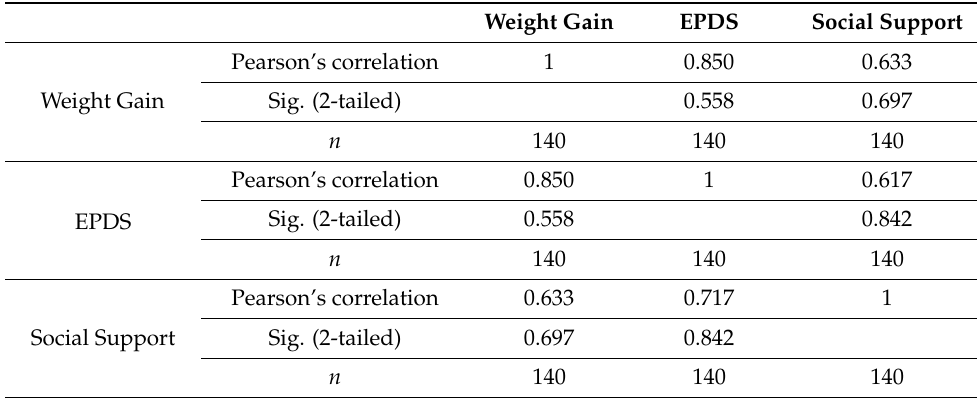
Table 7. Relations between Weight Gain, Depression and Social